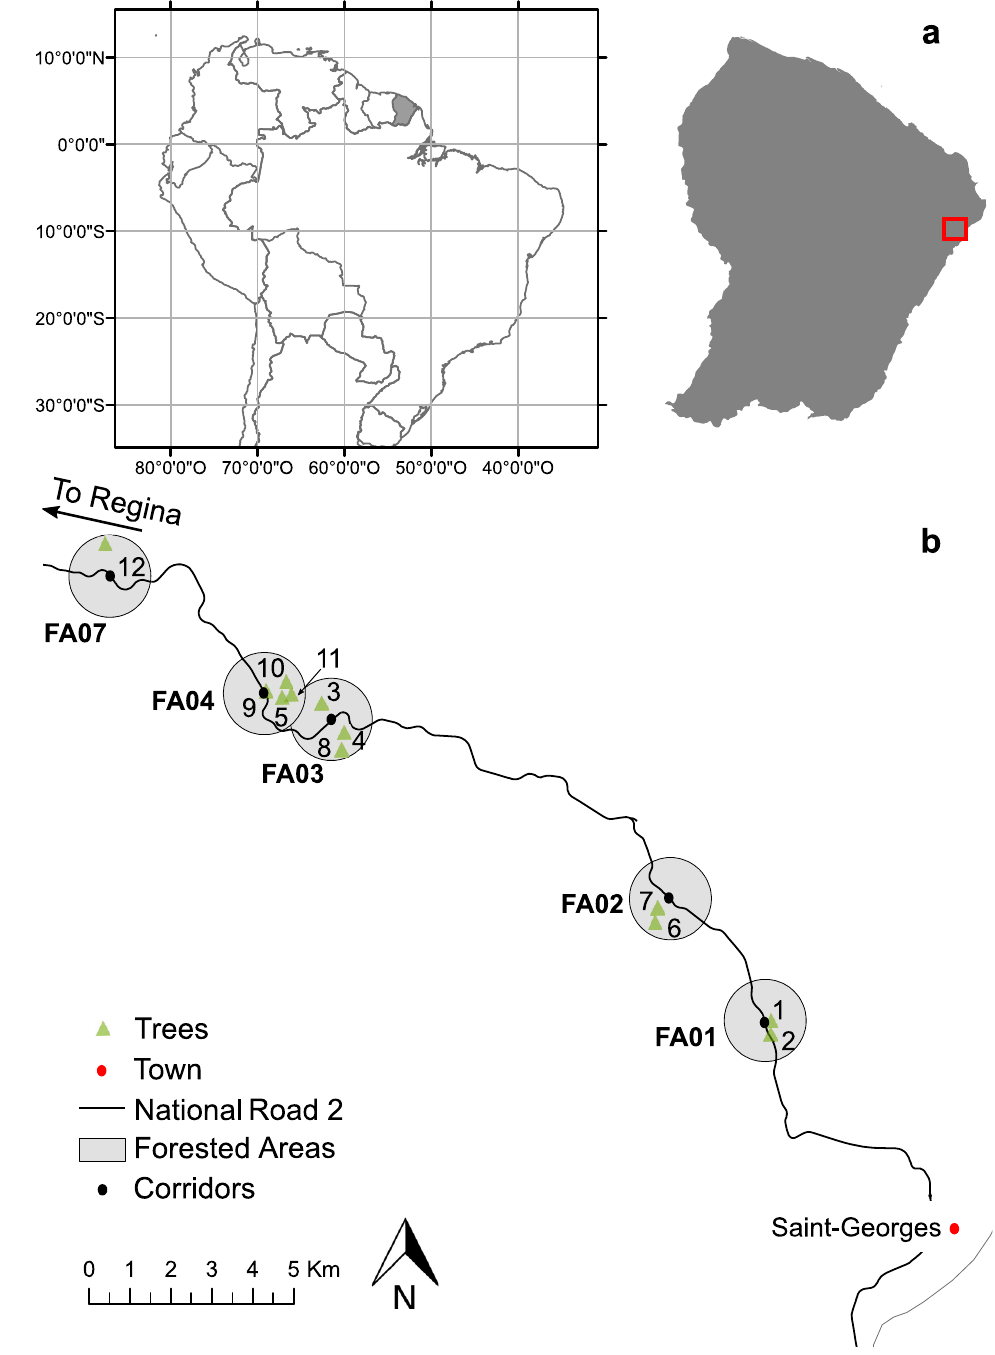
Figure 1. Study trees in the forested areas (FA) surrounding the ecological corridors along the National 2 Road between Régina and Saint-Georges in French Guiana (see further description in Coutant et al . 2022 57 ). The map was edited on ArcMap software version 10.6.1 (https:// www. esri.